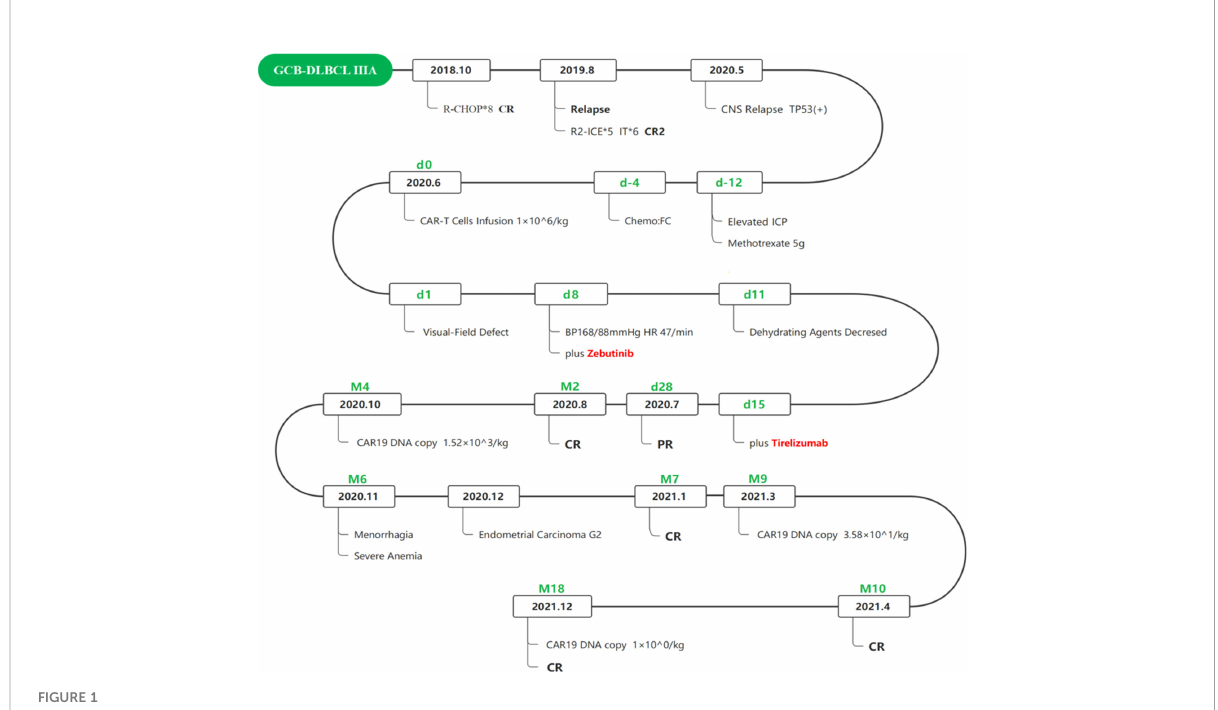
FIGURE 1 Flow chart of the disease process and therapeutic